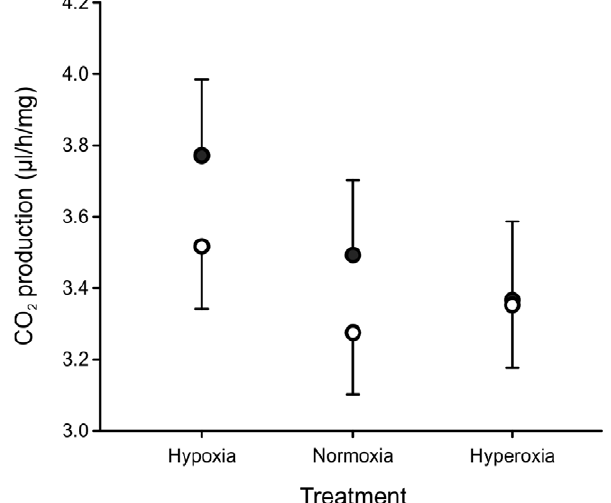
Figure 6. Variation among treatments in male and female activity levels as measured under normoxia at generation 49(44 hyperoxia). Mean number of movements within a 10 min period for male (solid) and female (dotted) D. melanogaster populations evolved under normoxic (black), hypoxic (blue), or hyperoxic (red) conditions and then raised in a common normoxic environment for two generations prior to conducting the assay. Treatment means are shown for clarity. The upper bar indicates the times at which the lights are on (white) and off (black) in the incubator. Activity varied significantly through time in a sex-specific manner, although treatments did not differ significantly (Table 4).